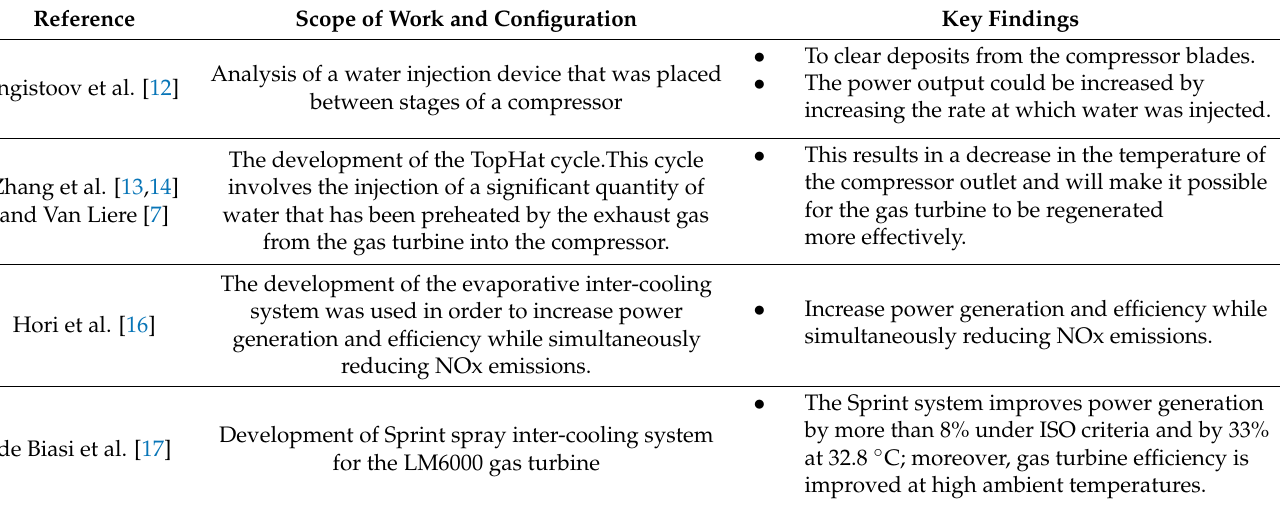
Figure 3. Schematic of the reheat gas turbine (AGTJ-100A). Table 1. A summary of the research efforts on wet compression and spray intercooling with water injection in the compressor.